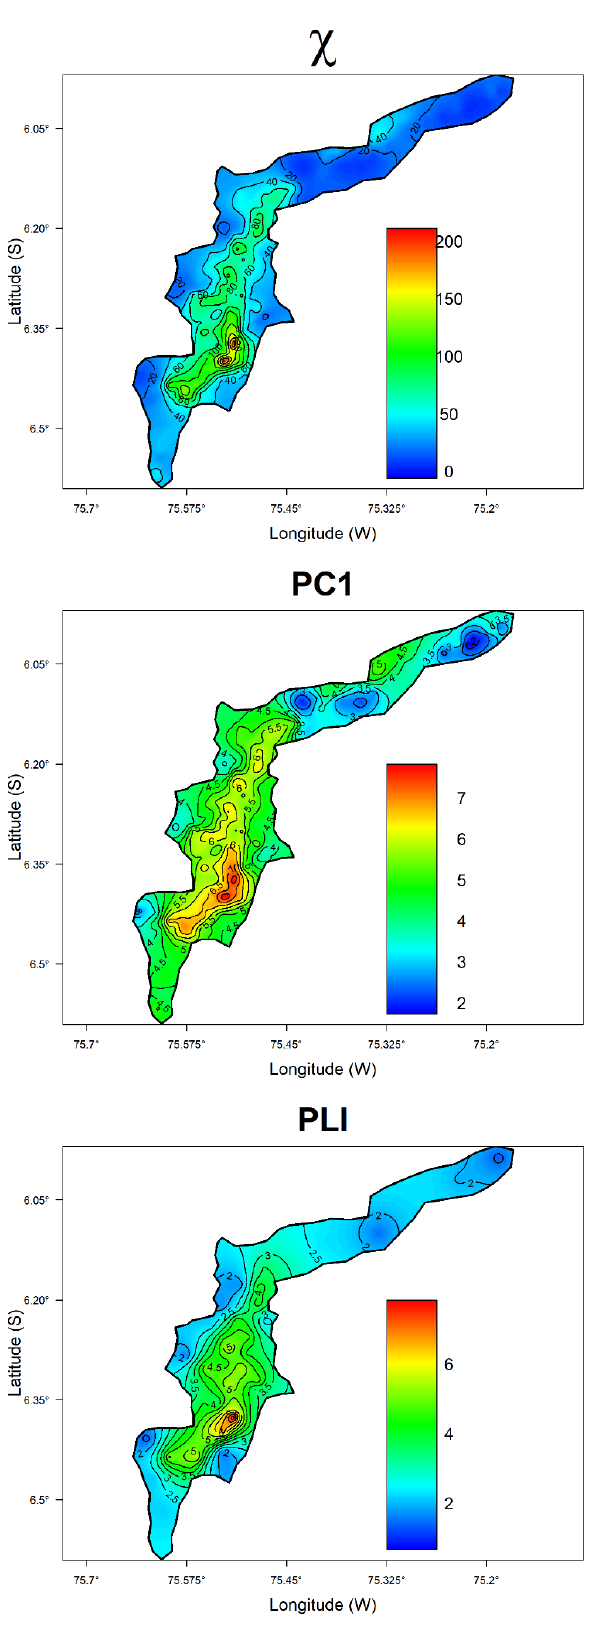
Figure 4. Prediction map of mass-specific magnetic susceptibility χ, principal component 1 (PC1: χ, ARM, SIRM, SIRM/χ, and χ/χ ARM ), and pollution index PLI .